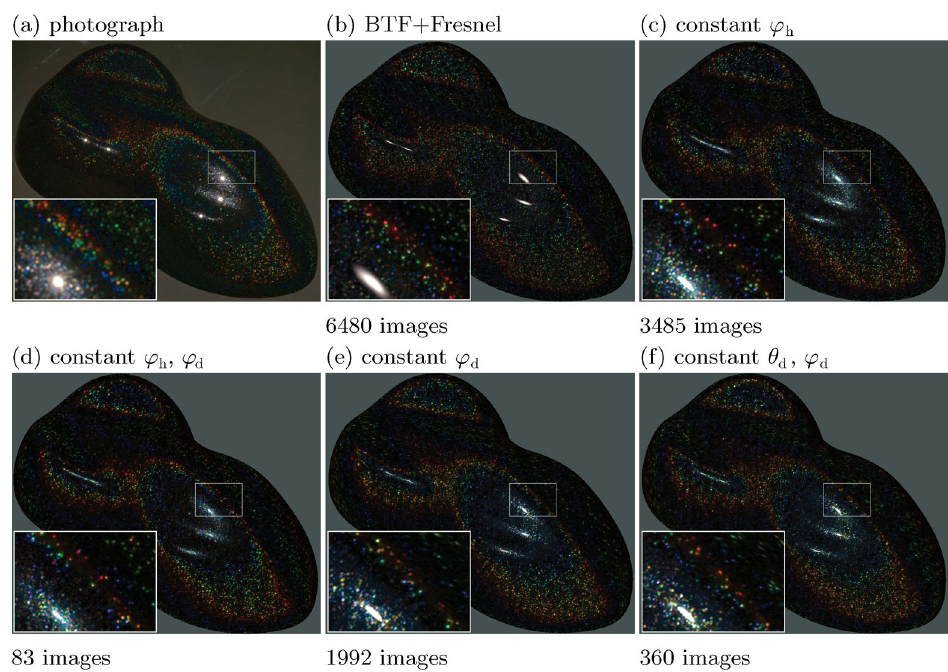
Fig. 9 Comparison between captured spatially-varying representations and photographs: (a) photographs of the coated object, (b) uniform BTF measurements with the specular highlight represented by Fresnel reflection, (c) isotropic representation using step a of 5 ◦ , (d) bivariate isotropic representation using 83 images (Δ θ h / Δ θ d = 5 ◦ / 15 ◦ ), (e) anisotropic representation (Δ θ h / Δ θ d / Δ ϕ h = 5 ◦ / 15 ◦ / 15 ◦ ), (f) bivariate anisotropic representation (Δ θ h / Δ ϕ h = 5 ◦ / 15 ◦ ).